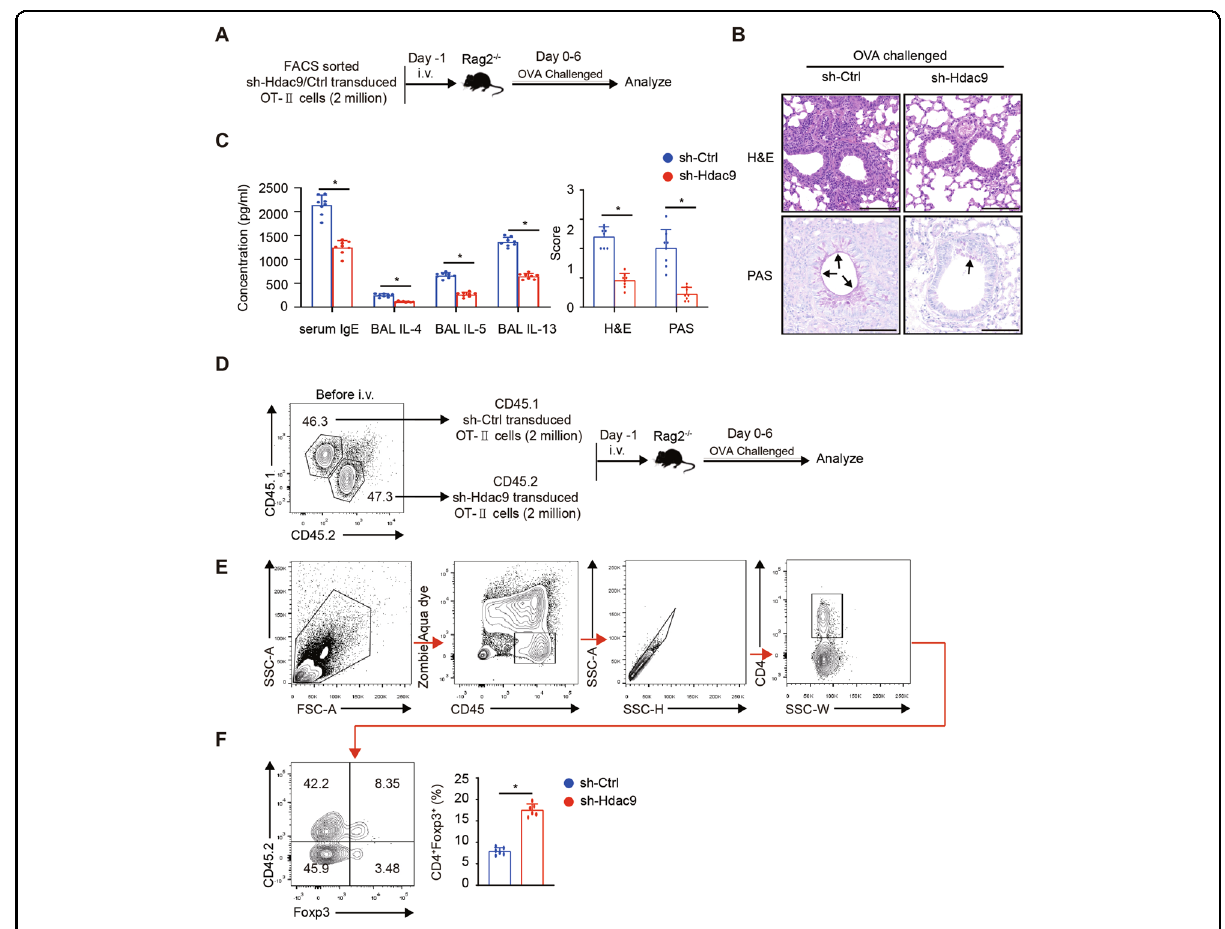
A Schematic representation of the Hdac9-knockdown OT-II cell transfer allergy model. B Representative lung histology sections displaying in fl ammatory cell in fi ltration and PAS + mucin-secreting cell hyperplasia. The arrow indicates purple-red mucin-producing cells. Scale bars, 100 µm. C Total IgE levels in the blood serum and IL-4, IL-5, and IL-13 levels in the BAL fl uid, as determined by ELISA. Graph displaying the histological scores determined by H&E and PAS staining. Five areas were randomly chosen in each slide. D Schematic representation of the CD45.1/2 + sh-Ctrl/Hdac9 OT-II cell transfer allergy model. E Gating strategy of CD4 + Foxp3 + Tregs in fi ltrated in lungs. F The percentages of Foxp3 + cells among CD45.1 + or CD45.2 + CD4 + T cells were displayed by contour plot and histogram. The Each group included six to eight mice. Data are the mean ± SD and representative of three independent experiments. * p <